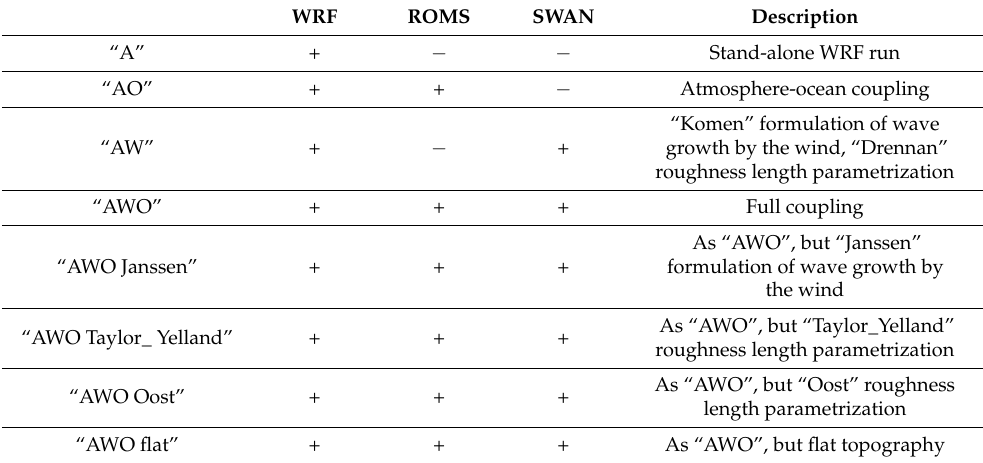
Table 1. List of